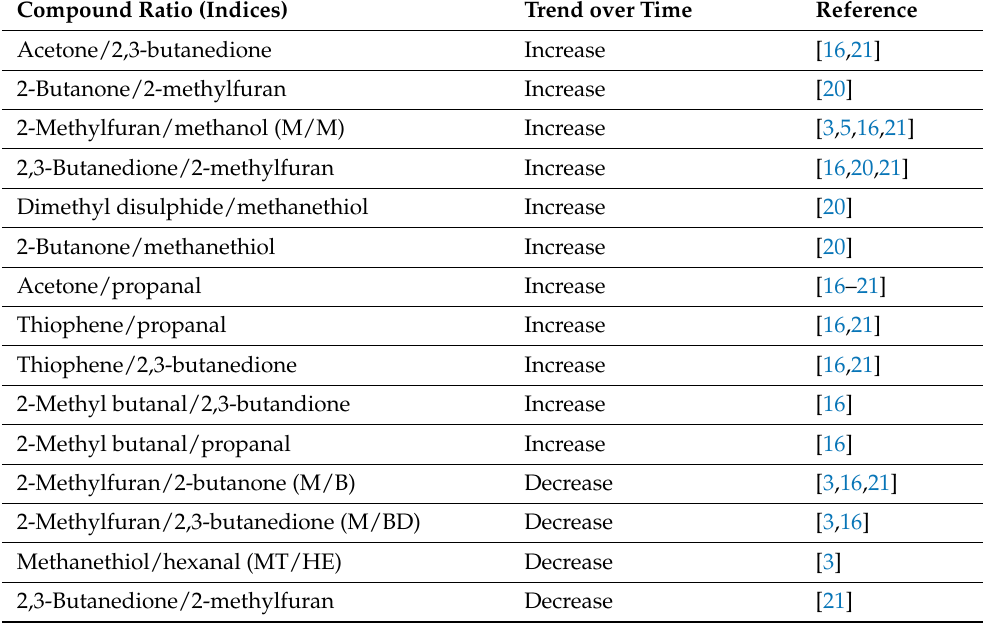
Table 1. Indices of coffee ageing from a literature survey, data adapted from references column. Compound Ratio (Indices) Trend over Time